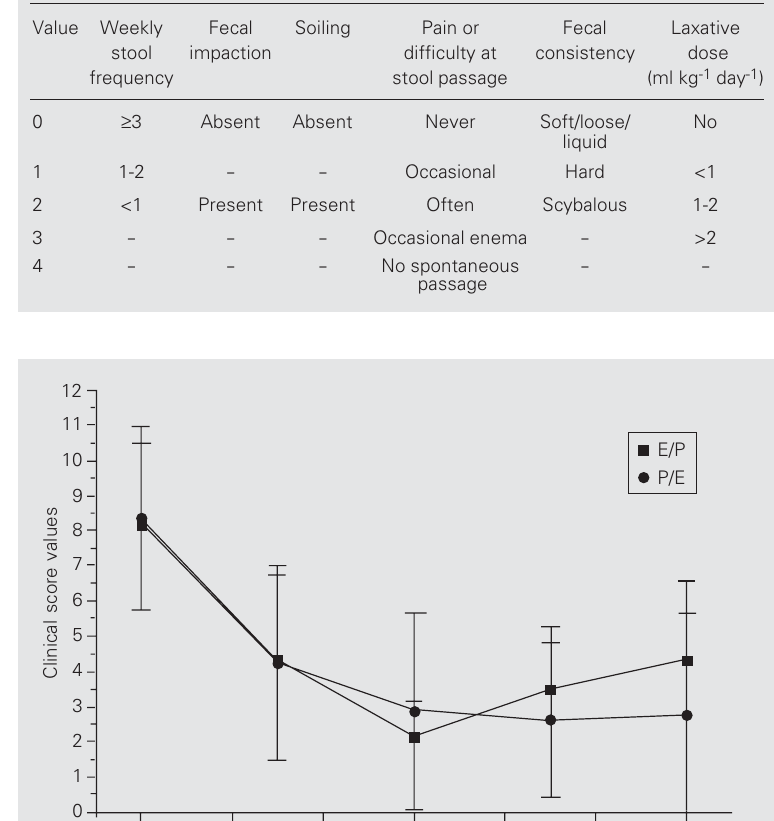
Table 1. Parameters used to assess clinical outcome and respective clinical